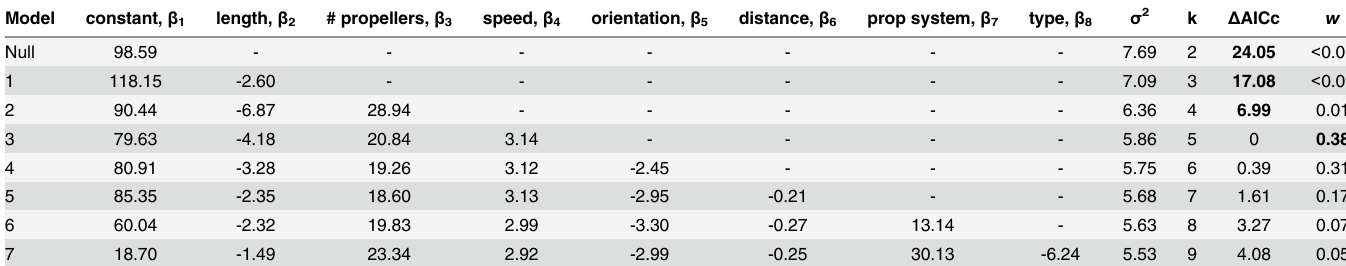
Results of the negative log likelihood model (for all complete intervals, including research vessel-only intervals, n = 57). Model parameters are the vessel characteristics that contribute to received noise. The model that best fi t the data was model 3. However, models with additional parameters also had an adequate amount of weight but due to the nature of AICc, could represent uninformative